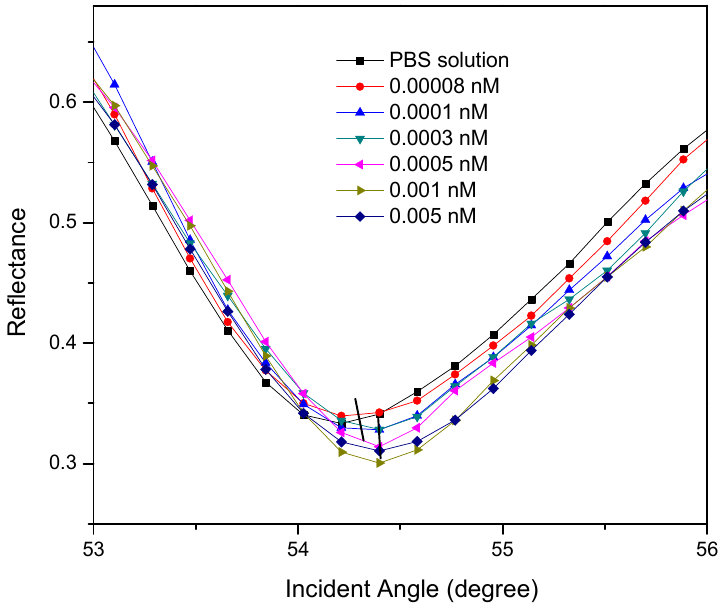
Figure 3. The reflectance curves of 0.00008–0.005 nM of DENV-2 E-protein detection. Next, the Au/DSU/NH 2 rGO–PAMAM/IgM-based SPR sensor response towards a lower range of DENV-2 E-protein concentration (0.000008 nM to 0.0001 nM) was conducted to determine the lowest detectable concentration for DENV-2 E-proteins, or on the other hand, to determine the detection limit obtained by this sensor. In this regard, the limit of detection (LOD) is derived by the capability of the sensor to distinguish the SPR response of DENV-2 E-protein detection and reference solution detection [78]. The results depicted in